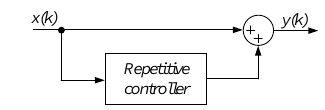
Figure 14. Plug-in repetitive controller.